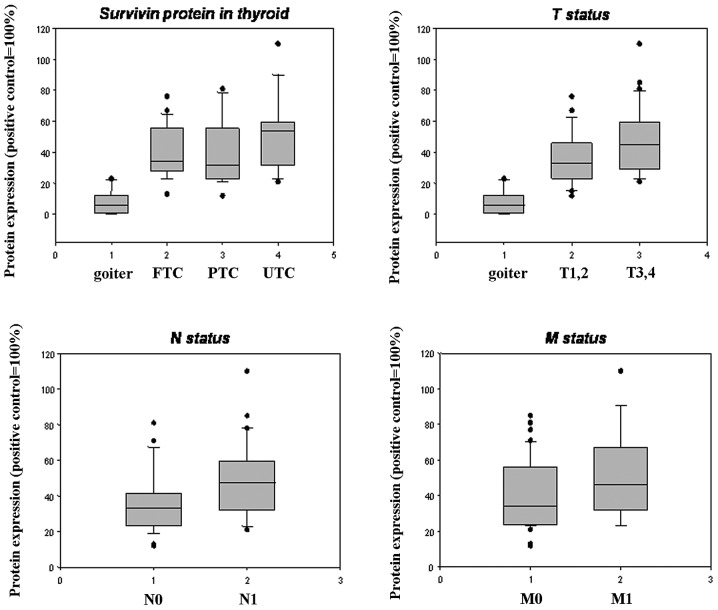
Correlation between the protein expression of endogenous survivin and various clinicopathological parameters. Protein expression of endogenous survivin was significantly correlated with the grade of tumor invasiveness T and local lymph node metastasis (N); and with distant metastasis (M) of thyroid carcinoma tissues but this value did not achieve statistical significance.